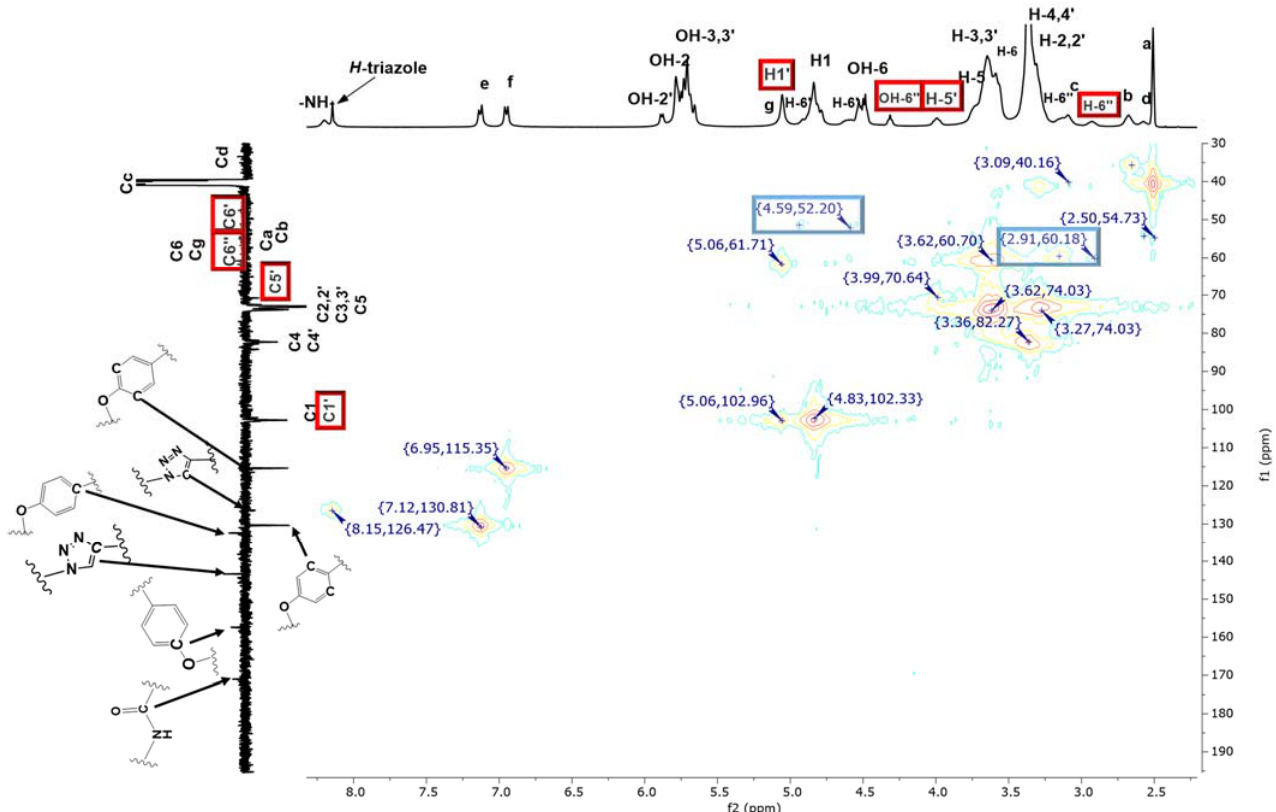
Figure 3. HMQC ‐ NMR spectra of EDTA G0 ‐β CD dendrimer. Figure 3. HMQC-NMR spectra of EDTA G0- β CD